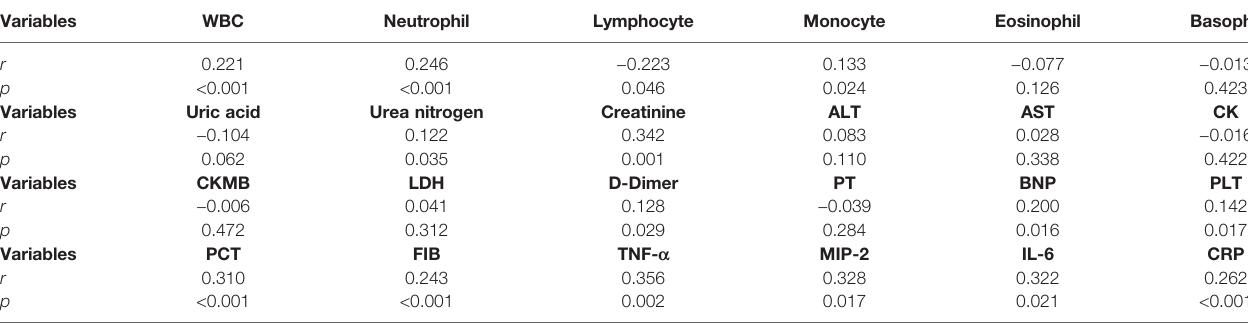
WBC, white blood cell; ALT, alanine aminotransferase; AST, aspartate aminotransferase; CK, creatine kinase; CKMB, creatine kinase isoenzyme; LDH, lactate dehydrogenase; PT, prothrombin; BNP, brain natriuretic peptide; PLT, platelet; PCT, procalcitonin; FIB, fi brinogen; TNF- a , tumor necrosis factor alpha; MIP-2, macrophage in fl ammatory protein-2; IL-6, interleukin-6; CRP, C-reactive